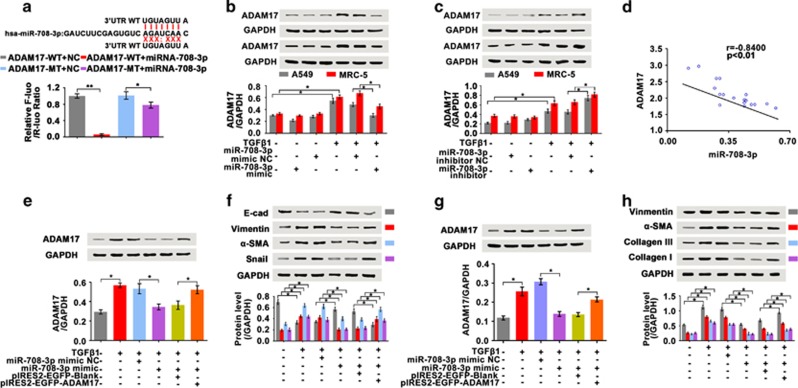
Identification of the miR-708-3p-targeted gene. (a) Sequences of miR-708-3p and the potential miR-708-3p binding site at the 3′UTR of ADAM17. The nucleotides mutated in the ADAM17-3′UTR mutant are also shown. The luciferase activity of WT 3′UTR-ADAM17 significantly decreased in the cells transfected with miR-708-3p mimics, whereas the miR-708-3p mimics could not inhibit the luciferase activity of MU 3′UTR-ADAM17. (b) The miR-708-3p mimic inhibited ADAM17 expression in A549 and MRC-5 cells. (c) The miR-708-3p inhibitor promoted ADAM17 expression in A549 and MRC-5 cells. (d) Pearson correlation coefficient showed that miR-708-3p inversely correlated with ADAM17. (e–h) Rescue experiments (miR-708-3p mimic+ADAM17 overexpression) confirmed ADAM17 as the target of miR-708-3p in A549 and MRC-5 cells, respectively. Each bar represents the mean±s.d.; n=6, *P< 0.05, **P<0.01.